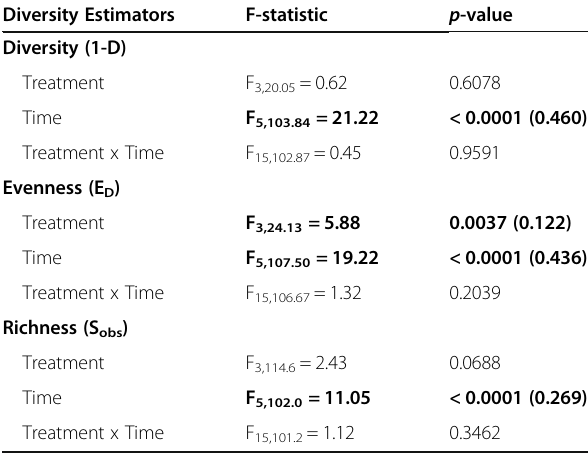
Table 1 Results of repeated measures ANOVAs on diversity estimators across treatment, time and their interaction. F statistics are included with degrees of freedom (F df, dfDen ) where dfDen is the denominator df based on Kenward-Roger first order approximations with Kacker-Harville corrections. Where significant, partial η 2 effect sizes are presented parenthetically Diversity